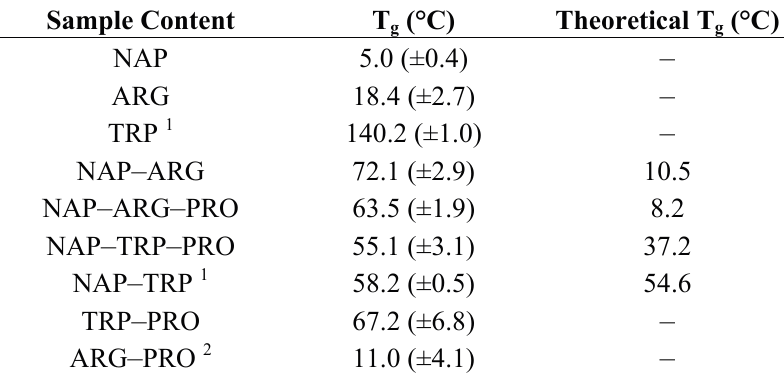
Table 2. Experimental T s of the pure amorphous quench-cooled NAP [26], amorphous g freeze-dried ARG, ball-milled TRP and ball-milled co-amorphous blends ( n = 3, mean ± standard